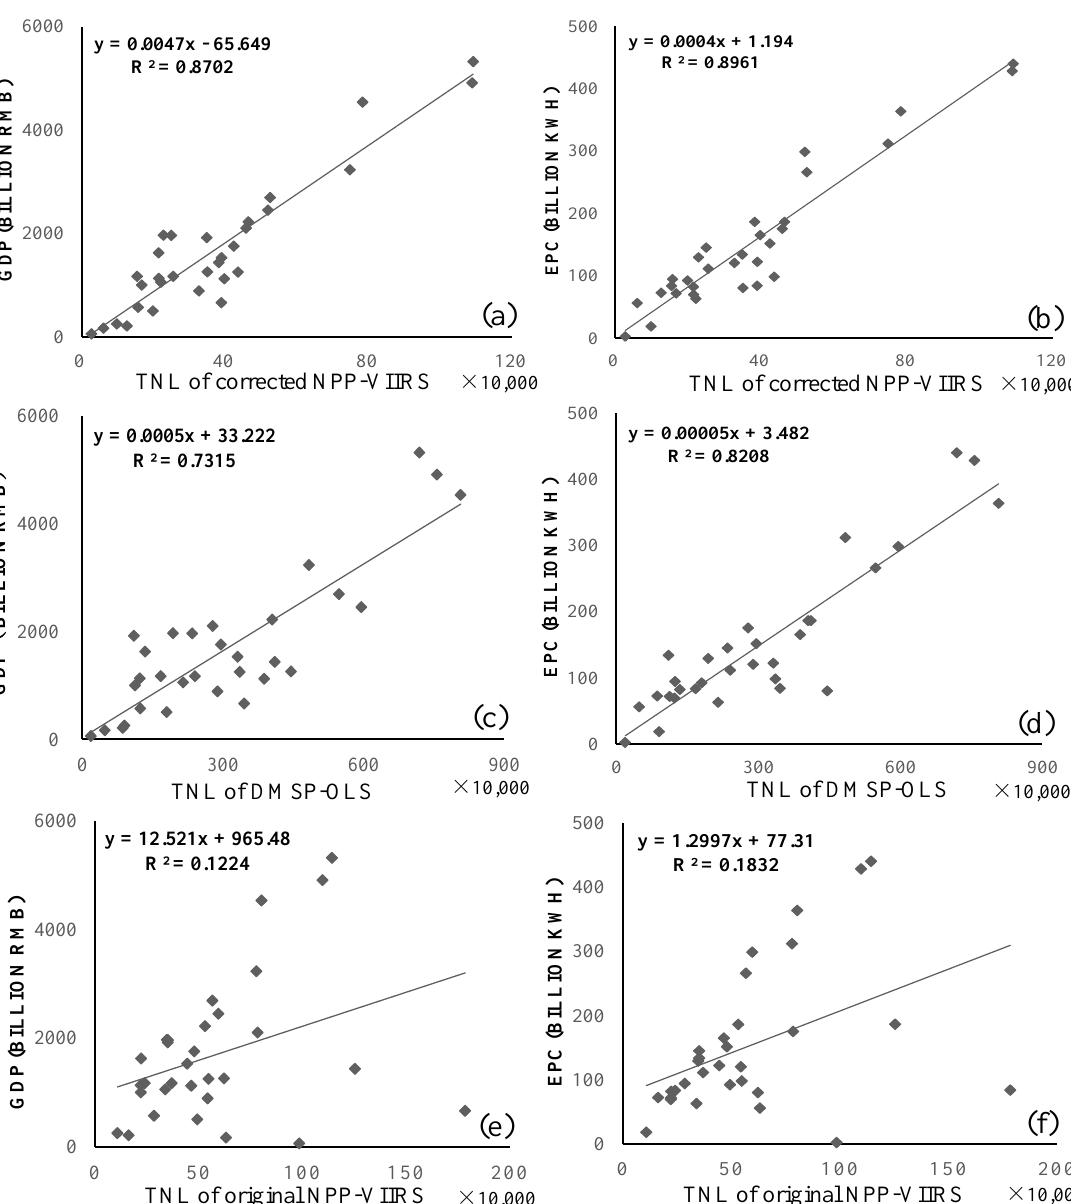
Figure 5. The scatter diagram of linear regression analysis in provincial units: ( a ) the total nighttime light (TNL) of corrected NPP-VIIRS data and the gross domestic product (GDP); ( b ) the TNL of corrected NPP-VIIRS data and the electric power consumption (EPC); ( c ) the TNL of DMSP-OLS data and the GDP; ( d ) the TNL of DMSP-OLS data and the EPC; ( e ) the TNL of original NPP-VIIRS data and the GDP; ( f ) the TNL of original NPP-VIIRS data and the